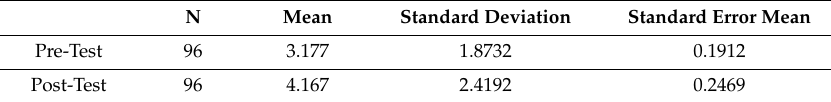
Table 3. Descriptive statistics for the pre-test and post-test values in Kindergarten.